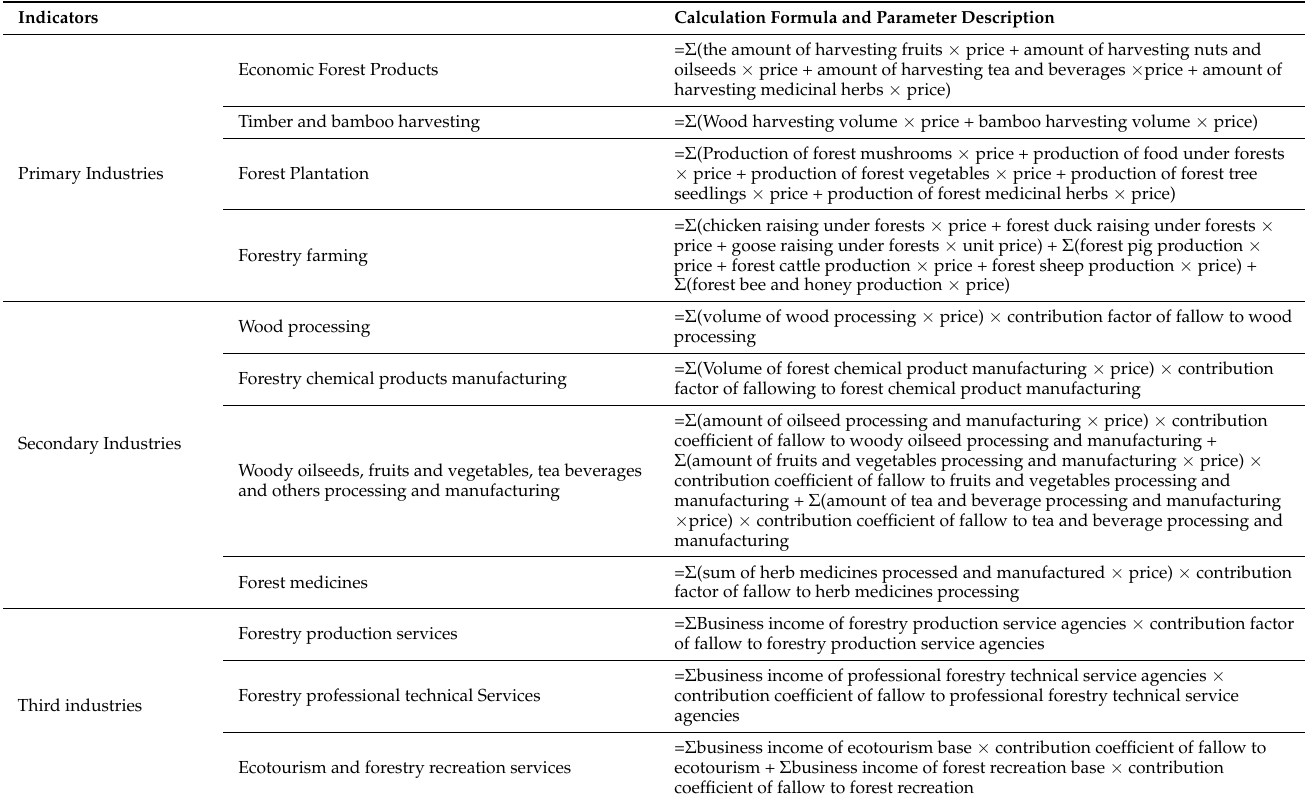
Table 2. Evaluation method of the economic benefit value of the CFFG